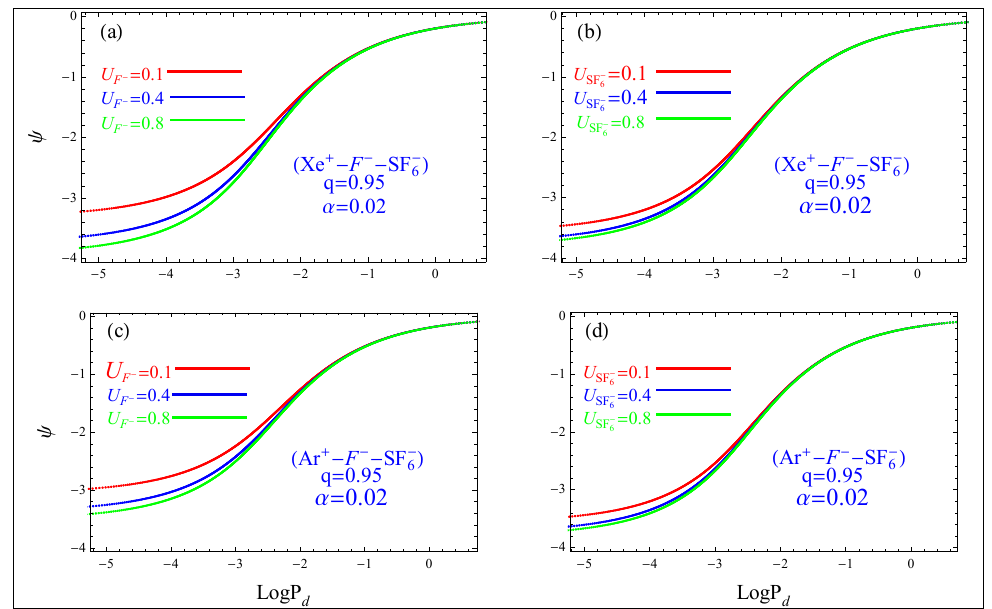
Figure 5. (Color online) ψ versus P d , ( a ) for U F − ( 0.1,0.4.0.8 ) with q = 0.95 and α = 0.02, ( 0.1,0.4.0.8 ) with q = 0.95 and α = 0.02 for xenon–fluorine–sulfur hexafluoride as given in ( b ) U SF − 6 Equation (10) ( c ) for U F − ( 0.1,0.4.0.8 ) with q = 0.95 and α = 0.02, ( d ) U